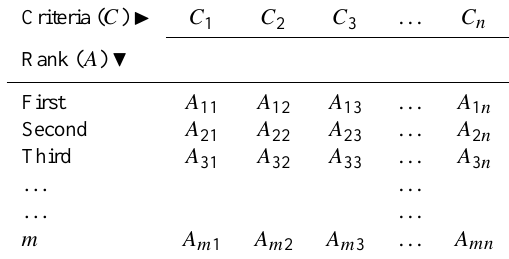
Table 7. Matrix ranking of each option against each